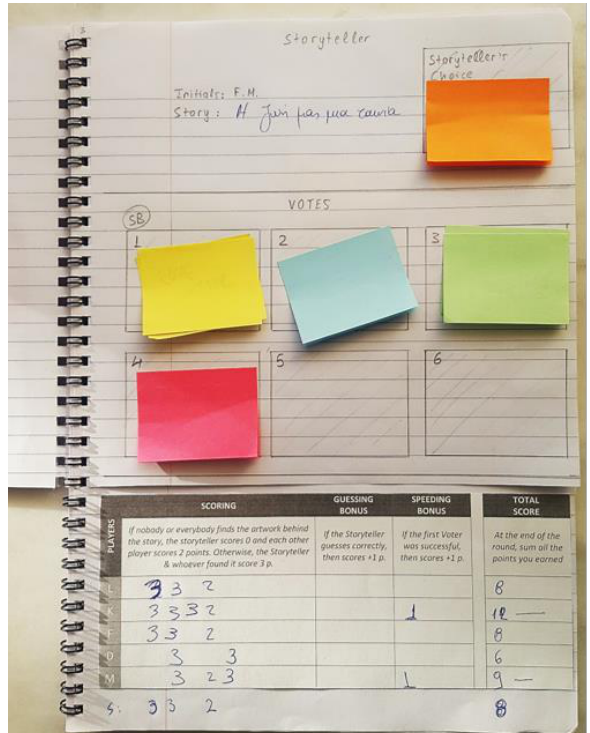
Figure 1. Exhibition environment.